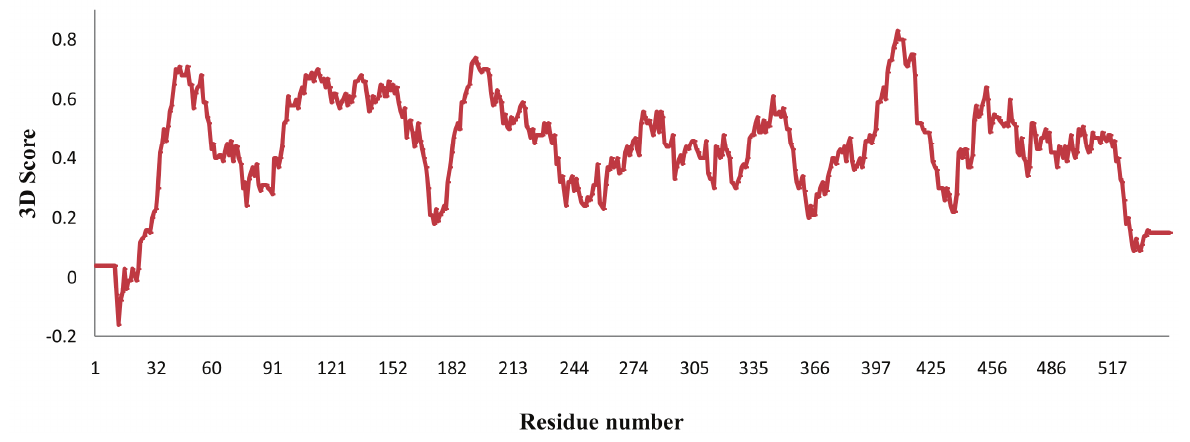
Figure 3. The 3D scores for the modeled myrosinase structure from Brassica oleracea